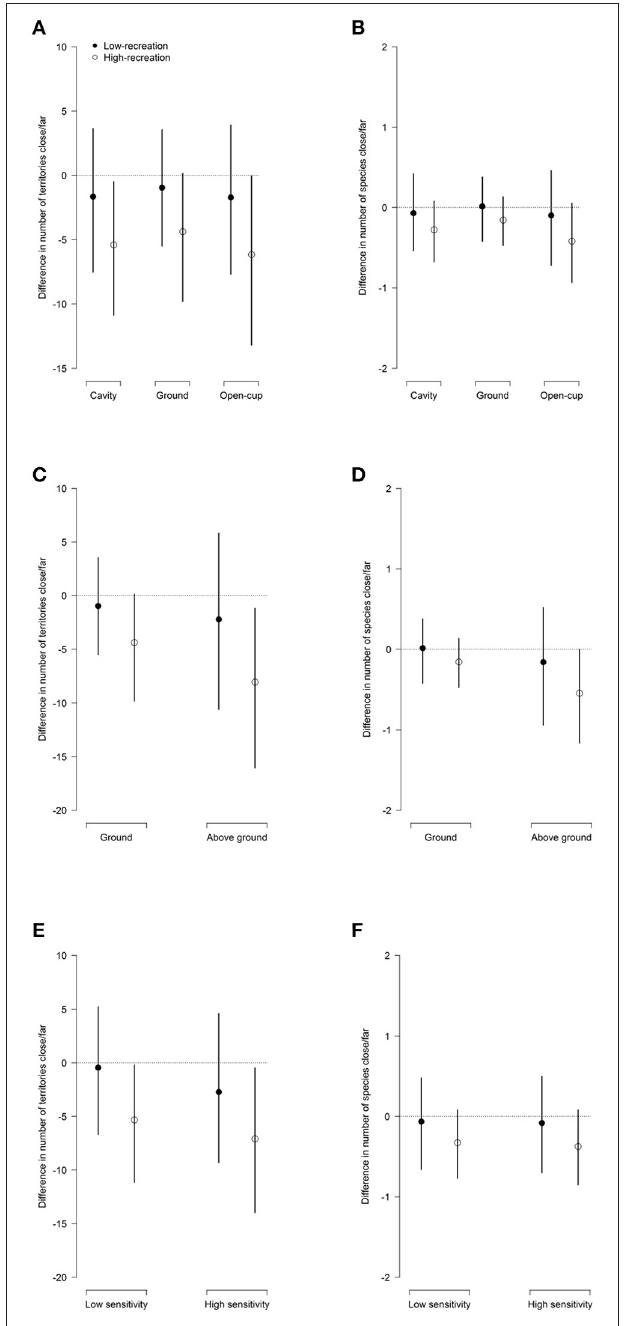
FIGURE 3 | Differences ( ± 95% CrI) in the estimated average number of territories (pooling all species within a group) between points close and far from trails in forests with high and low levels of recreation, according to (A,B) nesting-guild, (C,D) foraging-guild, and (E,F) sensitivity toward humans. See Figure 2 for further explanations about how to read the